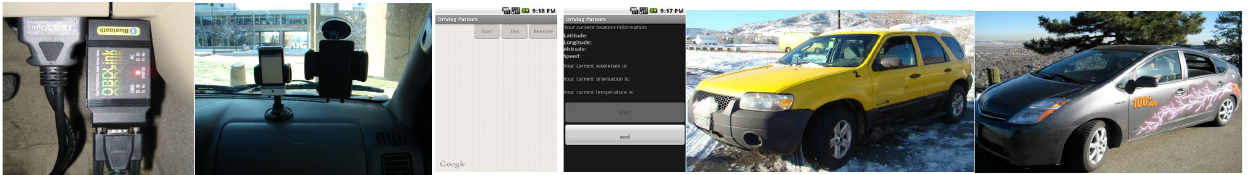
Figure 6. OBD and personal mobile devices deployed in PHEVs for real-time